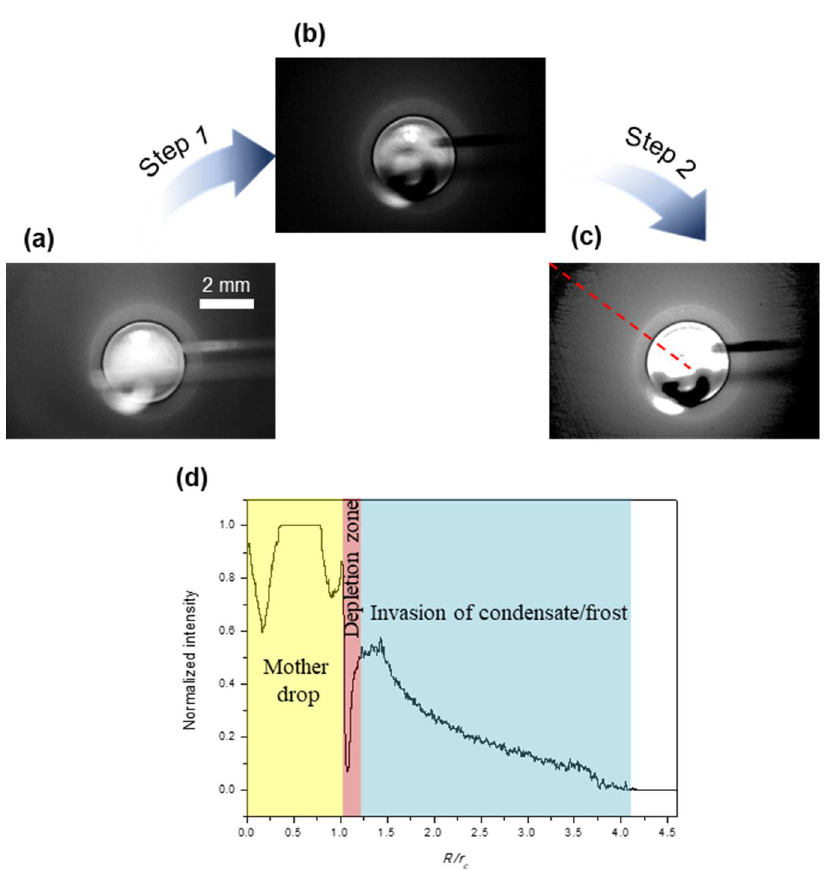
Figure 4. An example showing the imaging processing method ( a – c ) and the variation of normalized intensity along the radial direction ( d ).